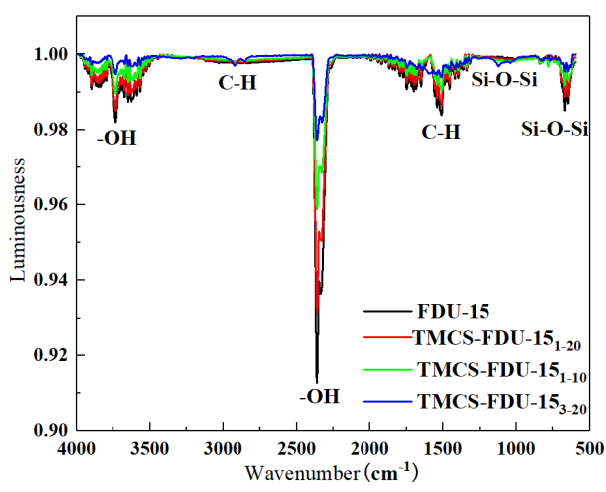
Figure 3. FTIR spectra of FDU-15 and modified FDU-15.